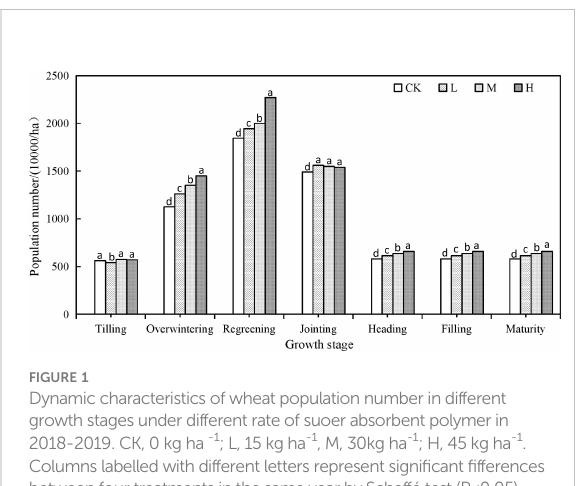
FIGURE 1 Dynamiccharacteristicsofwheatpopulation numberindifferent growthstagesunderdifferent rateofsuoerabsorbentpolymerin 2018-2019. CK, 0kgha -1 ;L,15kgha -1 ,M, 30kgha -1 ;H,45kgha -1